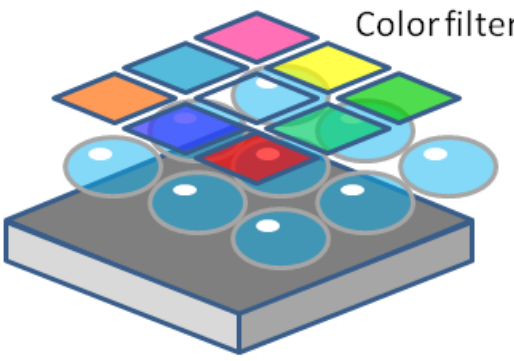
Figure 9. Color TOMBO compound eye imaging system.